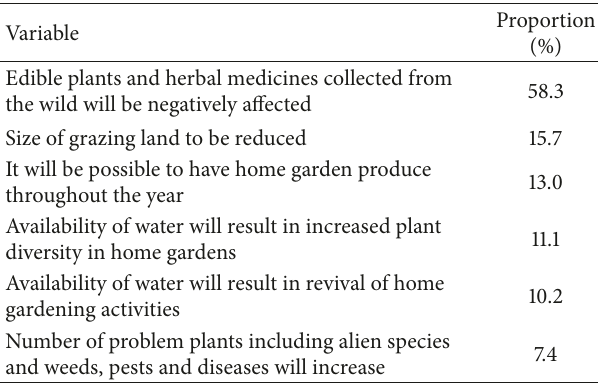
Table 3: Perceptions on possible impacts of dam construction on availability of plant resources in Ntabelanga catchment